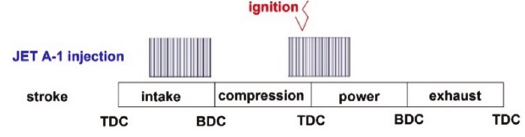
Fig. 1. Distribution of doses of JET A-1 fuel injection